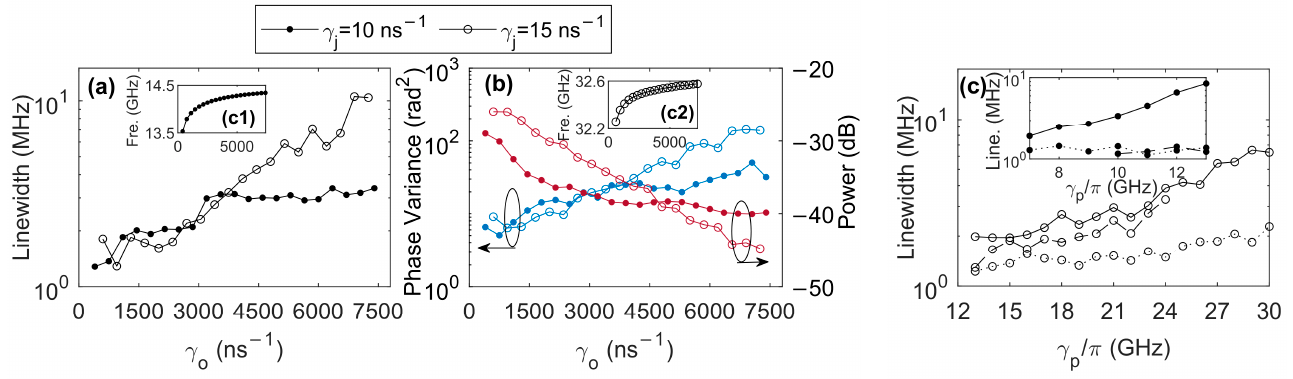
Figure 4. ( a1 , a2 ) Optical spectra and ( b1 , b2 ) RF spectra of the solitary optically pumped QD spin-VCSEL with ( a1 , b1 ) γ o = 400 ns − 1 and ( a2 , b2 ) γ o = 7000 ns − 1 . The spin relaxation rate is γ j = 10 ns − 1 , and other parameters are the same as those in Figure 1.